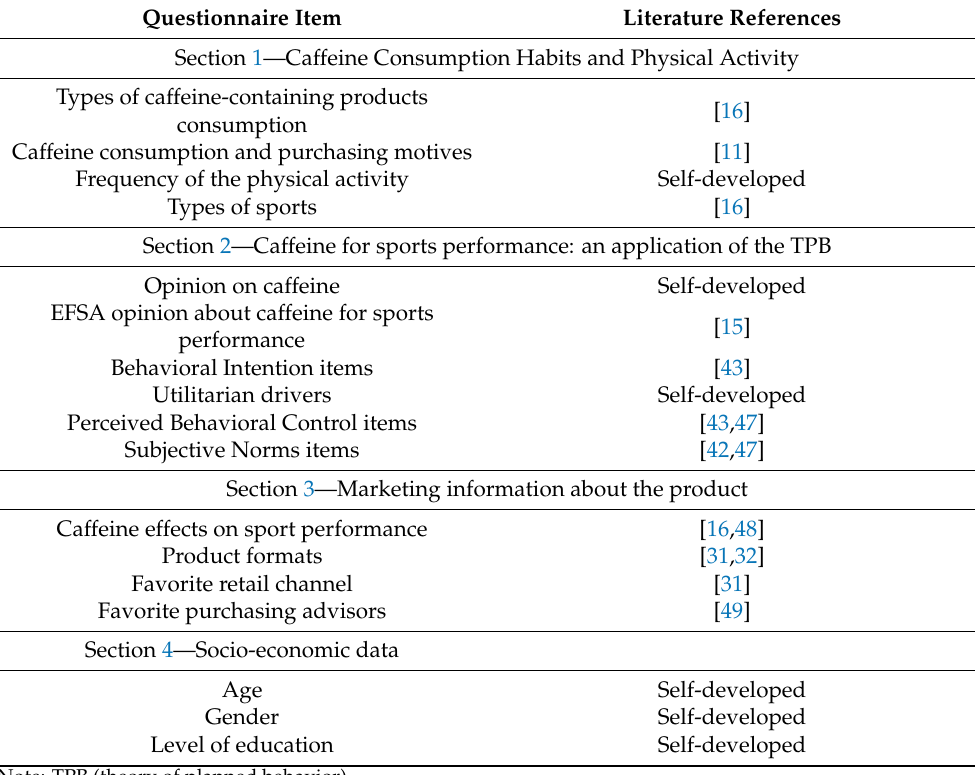
Table 1. Literature references for the questionnaire